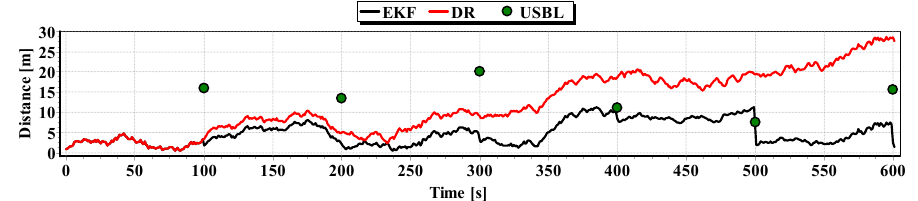
Figure 28. Graph of the reference position distance from the position estimated by EKF and DR methods and determined by the USBL system (single passage).